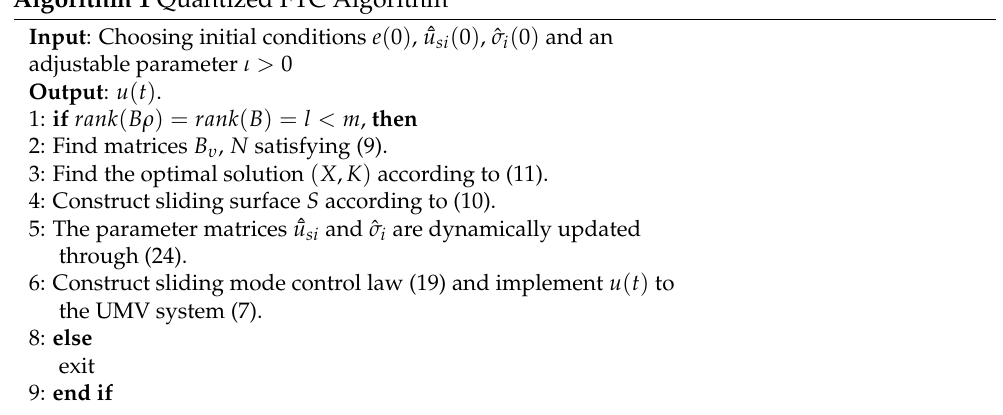
Algorithm 1 Quantized FTC